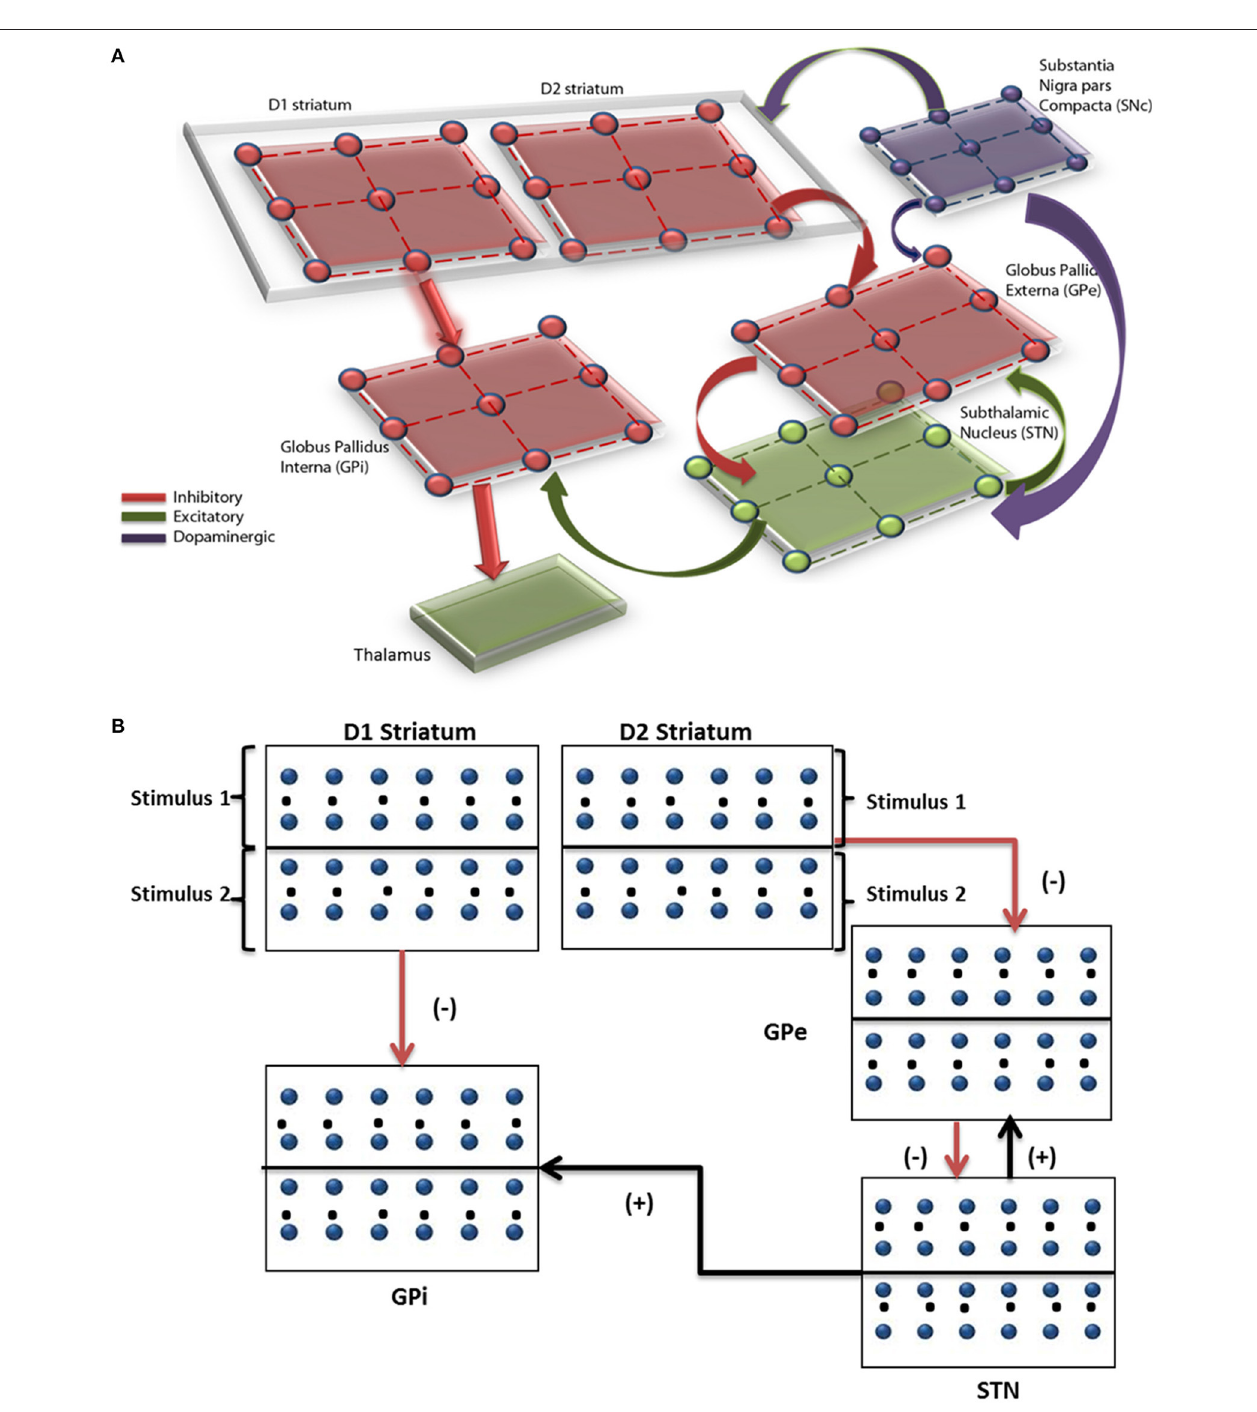
FIGURE 1 | Pictorial representation of the spiking basal ganglia model with all the key nuclei such as striatum, STN, GPi, GPe, SNc, and thalamus. (A) The synaptic projections were modeled as glutamatergic indicated by green color and GABAergic currents in red color. (B) Shows a graphical picture of how input stimuli were presented to the